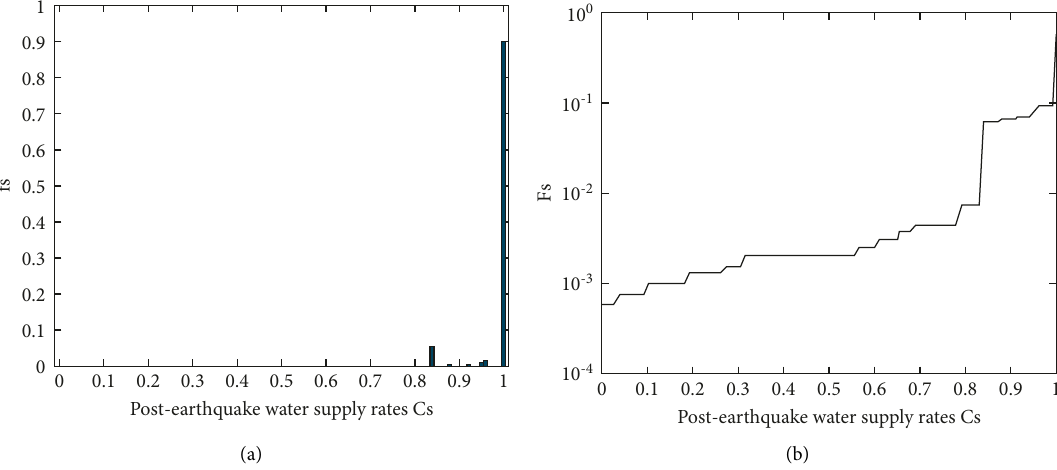
Figure 3: Post-earthquake water supply rate (cast iron pipe) with no liquefaction of intensity VII. (a) Probability mass function. (b) Cumulative distribution function.